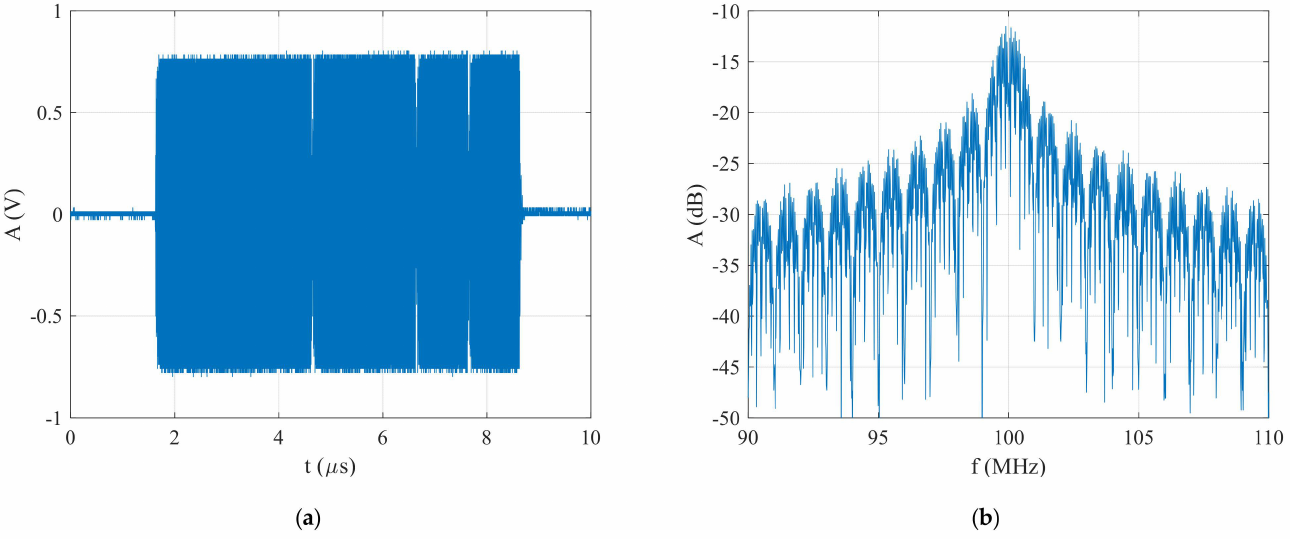
Figure 8. Generated BPSK signal in the form of Barker Code 7 without noise: ( a ) time domain, and ( b )